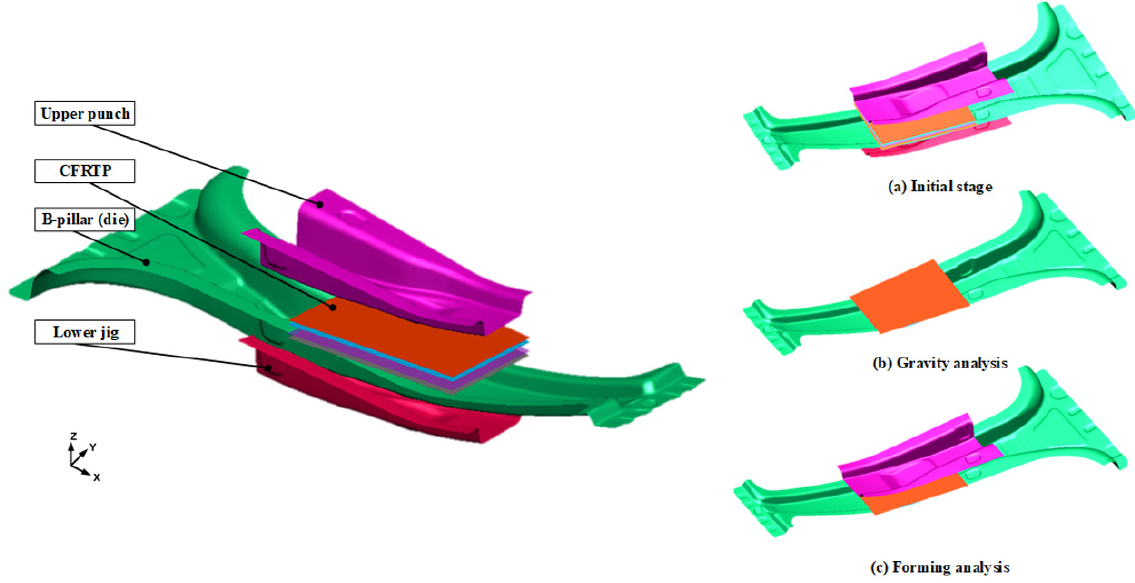
Figure 7. FE model and processes of thermoforming analysis of CFRP reinforcement on the B-pillar.